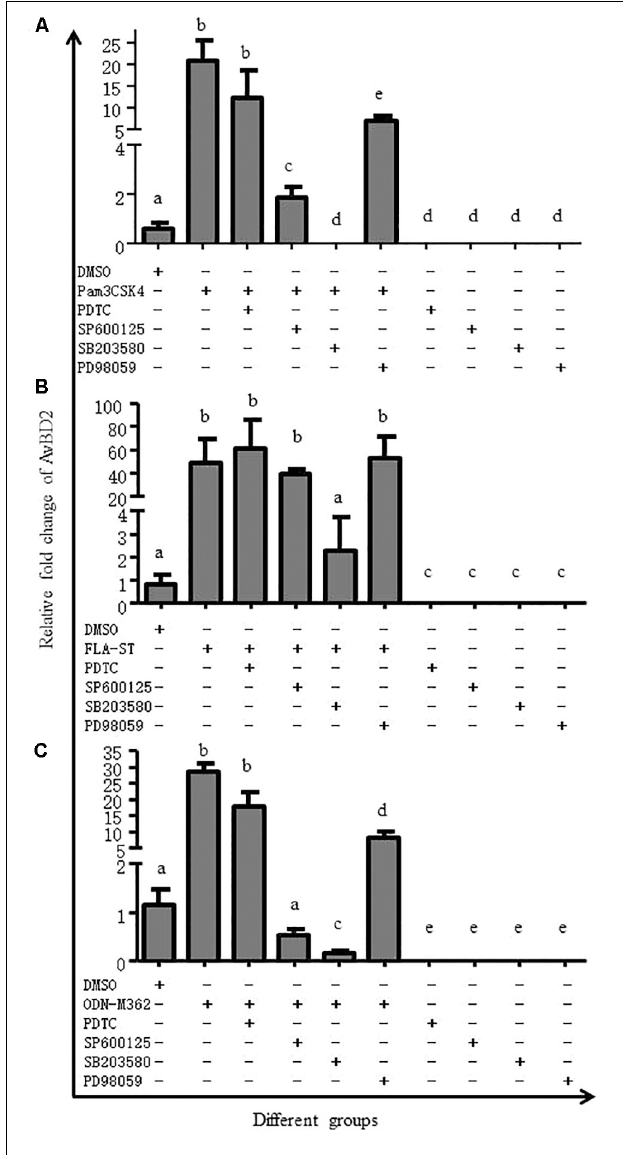
FIGURE 6 | MAPK signaling pathway is involved in AvBD2 induction mediated by TLR ligands. CEFs were pre-treated with 50 µ M PDTC (NF- κ B inhibitor), 50 µ M SP600125 (JNK inhibitor), 50 µ M SB203580 (p38 MAPK inhibitor), or 50 µ M PD98059 (ERK1/2 inhibitor) for 1 h, followed by stimulation with or without (A) Pam3CSK4 (0.4 µ g/ml), (B) FLA-ST (2 µ g/ml), or (C) ODN-M362 (2.5 µ M) for another 24 h. The DMSO group was used as a negative control. Fold change of mRNA expression in CEFs of each group were measured by RT-PCR at 24 h post-treatment. Transcript level of AvBD2 was normalized